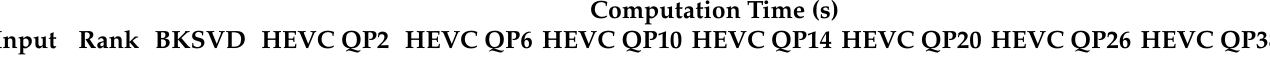
Table 6. Comparison of computation speed in BLOCK II of proposed scheme with (ML(3)) and without (AV(169)) multi- plicative layers. Experiment evaluated on Bikes light field for BK-SVD ranks 20 and